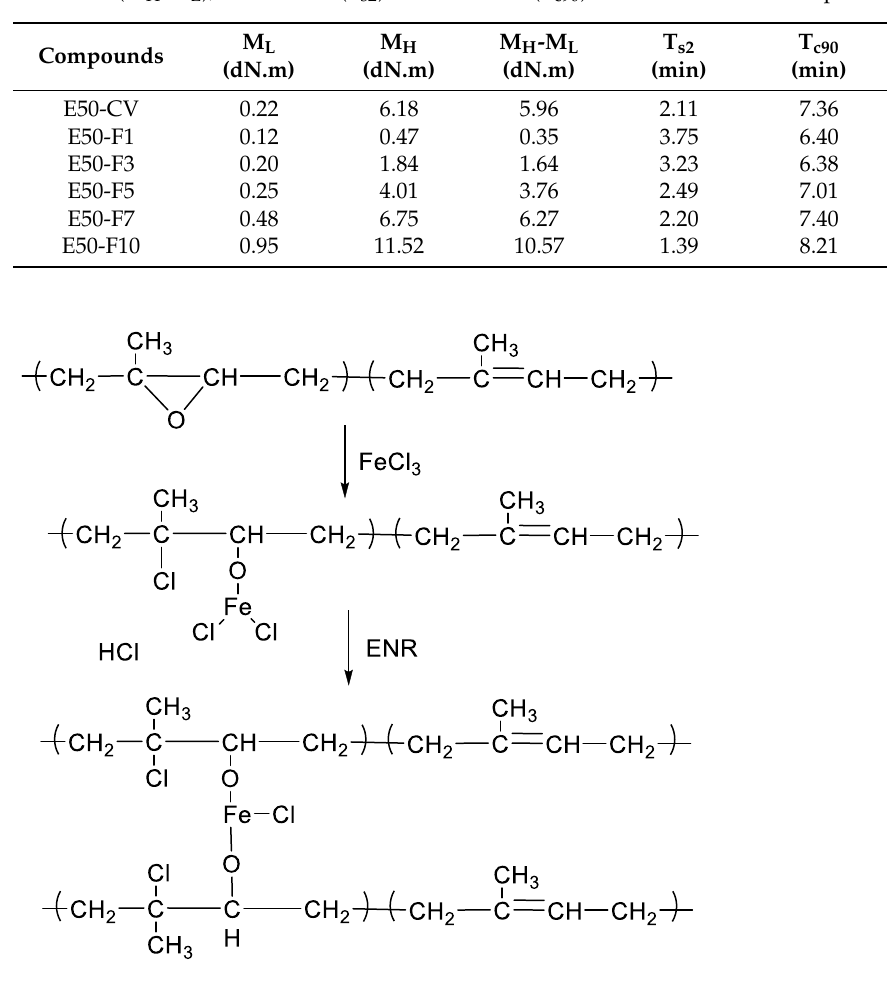
Table 3. Cure characteristics in terms of minimum torque (M L ), maximum torque (M H ), torque difference (M H -M L ), scorch time (T s2 ) and cure time (T c90 ) of various ENR-50 compounds.